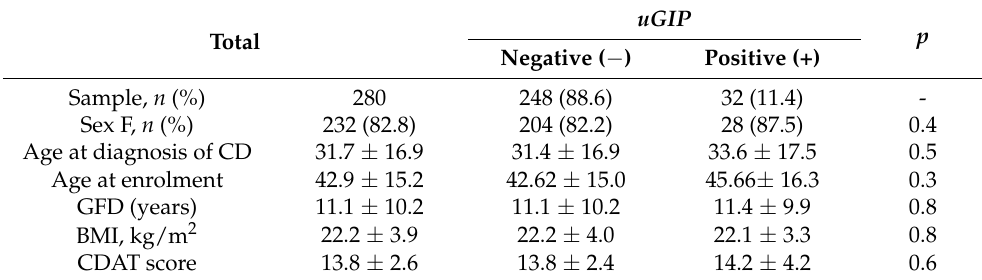
Table 1. Clinical and demographic characteristics of celiac patients with positive or negative urinary gluten immunogenic peptides (uGIP)